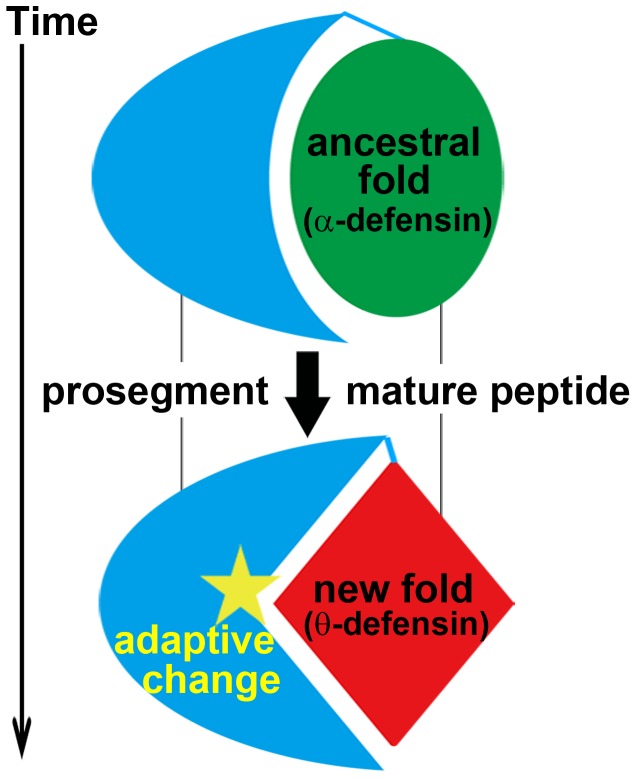
Coevolution of the prosegment with the new protein fold of the mature peptide.The ancestral protein fold refers to the α-defensin mature peptide, and the new protein fold refers to the θ-defensin mature peptide. Because the prosegment is important for the correct folding of the mature peptide, the prosegment coevolves with the mature peptide through adaptive changes.